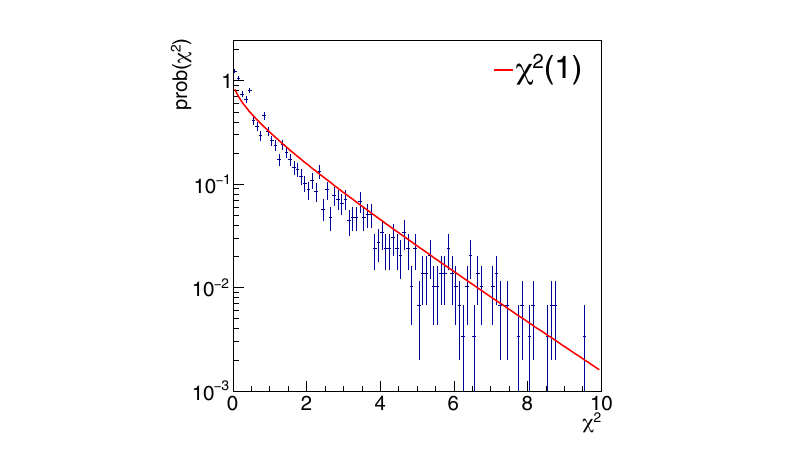
Figure 2. χ 2 distribution of the tracks in the output - blue points. Red line shows the probability density function for χ 2 distribution with one degree of freedom.